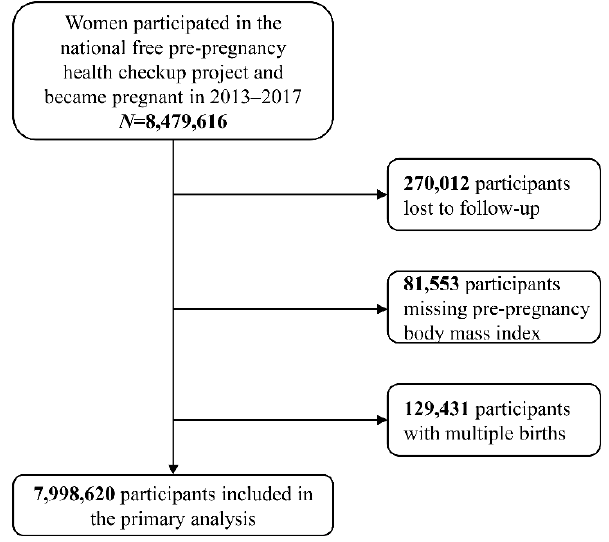
Figure 1. Flow chart for included participants.